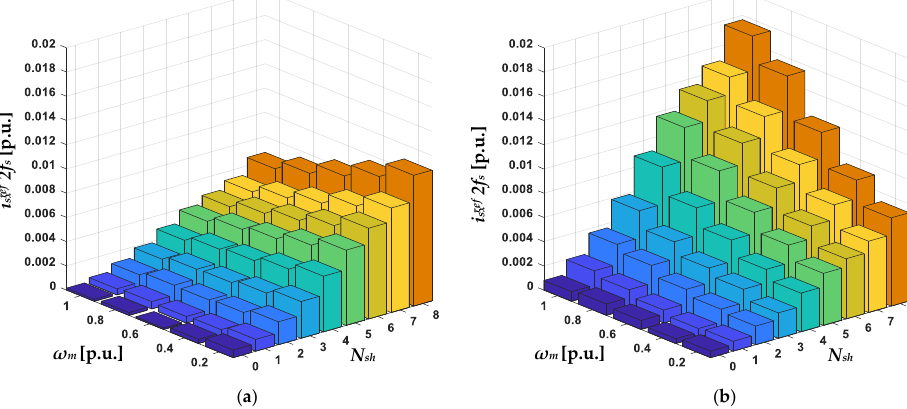
Figure 11. Amplitudes of the f sh harmonic of the i sx reference current component for different numbers of short-circuit turns and different load torques with ω m = 0.6 ω mN in the case of ( a ) speed measurement and ( b ) sensorless operation.